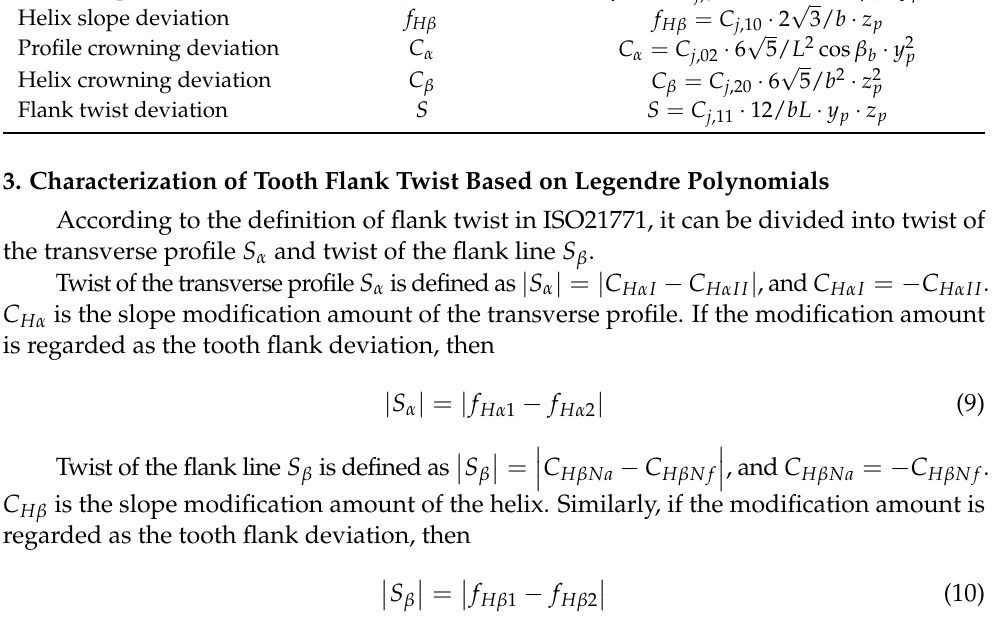
Relationship between C j , kl and Deviation of Flank